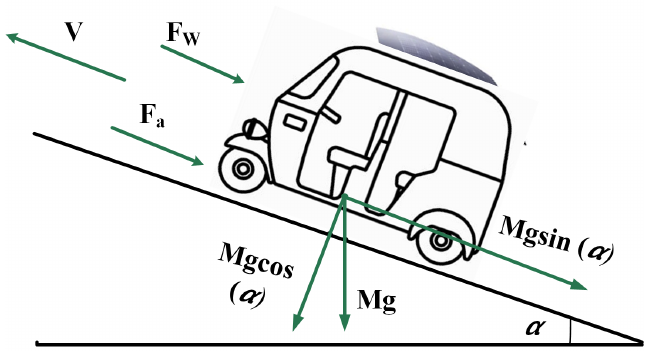
Figure 3. Dynamics of electric three-wheeler vehicle.